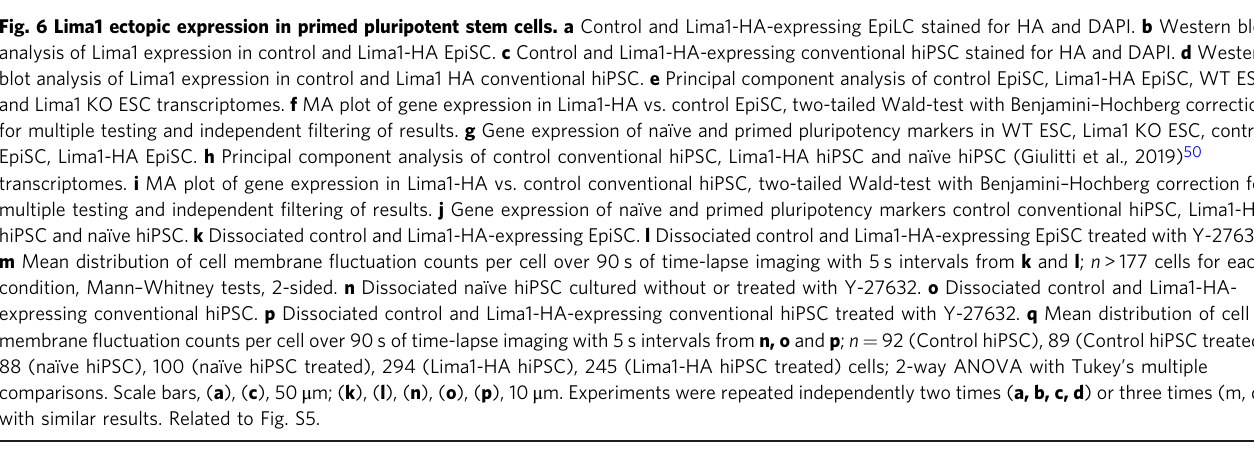
Fig. 6 Lima1 ectopic expression in primed pluripotent stem cells. a Control and Lima1-HA-expressing EpiLC stained for HA and DAPI. b Western blot analysis of Lima1 expression in control and Lima1-HA EpiSC. c Control and Lima1-HA-expressing conventional hiPSC stained for HA and DAPI. d Western blot analysis of Lima1 expression in control and Lima1 HA conventional hiPSC. e Principal component analysis of control EpiSC, Lima1-HA EpiSC, WT ESC and Lima1 KO ESC transcriptomes. f MA plot of gene expression in Lima1-HA vs. control EpiSC, two-tailed Wald-test with Benjamini – Hochberg correction for multiple testing and independent fi ltering of results. g Gene expression of naïve and primed pluripotency markers in WT ESC, Lima1 KO ESC, control EpiSC, Lima1-HA EpiSC. h Principal component analysis of control conventional hiPSC, Lima1-HA hiPSC and naïve hiPSC (Giulitti et al., 2019) 50 transcriptomes. i MA plot of gene expression in Lima1-HA vs. control conventional hiPSC, two-tailed Wald-test with Benjamini – Hochberg correction for multiple testing and independent fi ltering of results. j Gene expression of naïve and primed pluripotency markers control conventional hiPSC, Lima1-HA hiPSC and naïve hiPSC. k Dissociated control and Lima1-HA-expressing EpiSC. l Dissociated control and Lima1-HA-expressing EpiSC treated with Y-27632. m Mean distribution of cell membrane fl uctuation counts per cell over 90 s of time-lapse imaging with 5 s intervals from k and l ; n > 177 cells for each condition, Mann – Whitney tests, 2-sided. n Dissociated naïve hiPSC cultured without or treated with Y-27632. o Dissociated control and Lima1-HA- expressing conventional hiPSC. p Dissociated control and Lima1-HA-expressing conventional hiPSC treated with Y-27632. q Mean distribution of cell membrane fl uctuation counts per cell over 90 s of time-lapse imaging with 5 s intervals from n, o and p ; n = 92 (Control hiPSC), 89 (Control hiPSC treated) 88 (naïve hiPSC), 100 (naïve hiPSC treated), 294 (Lima1-HA hiPSC), 245 (Lima1-HA hiPSC treated) cells; 2-way ANOVA with Tukey ’ s multiple comparisons. Scale bars, ( a ), ( c ), 50 μ m; ( k ), ( l ), ( n ), ( o ), ( p ), 10 μ m. Experiments were repeated independently two times ( a, b, c, d ) or three times (m, q) with similar results. Related to